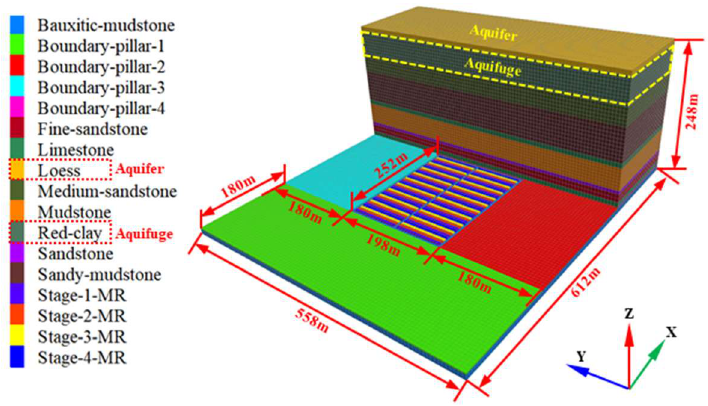
Figure 10. Numerical calculation model for simulating the aquifuge deformation under CECB.